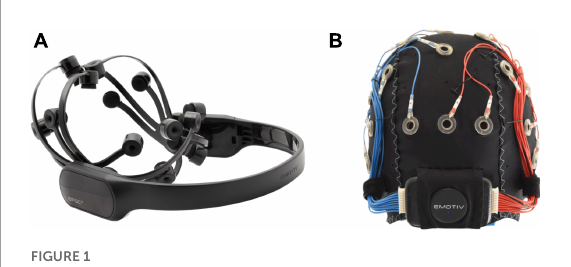
FIGURE1 Emotiv BCI headsets. (A) Headband-style Emotiv Epoc X with 14 electrodes on flexible plastic arm bands; (B) cap-style